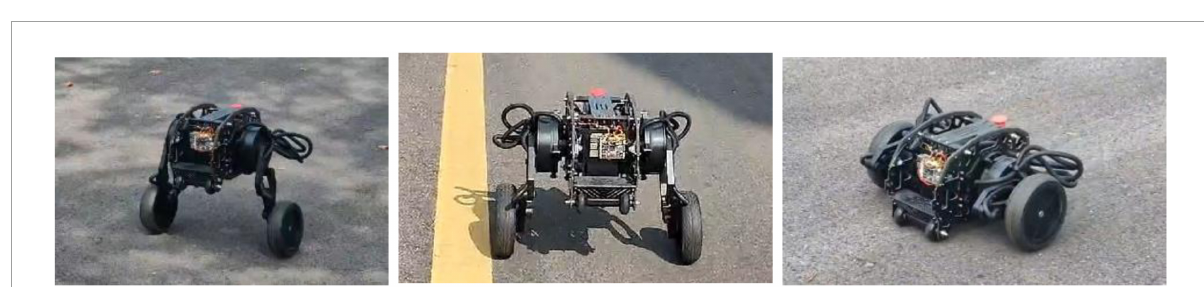
FIGURE20 Schematic diagram of different motion states.